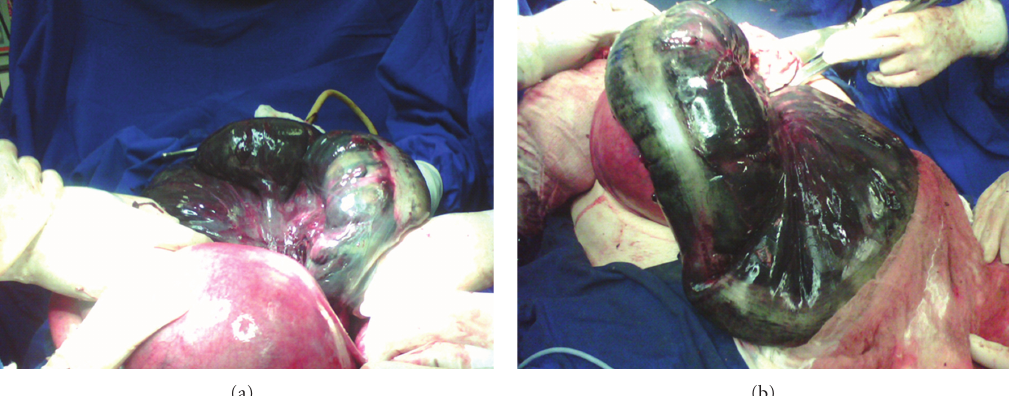
Figure 2: (a) Necrosis of the sigmoid colon after the pregnant uterus. Volvo, (b) complete necrosis of the sigmoid colon and descending portion of the transverse